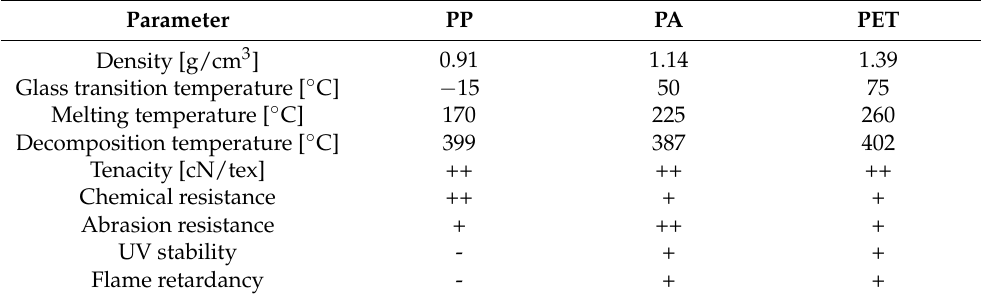
Table 1. Parameters for the physical properties of petrochemical polymers (++ very good, + sufficient, - insufficient [5–11]. Parameter PP PA PET Density [g/cm 3 ] 0.91 1.14 1.39 Glass transition temperature [ ◦ C] − 15 50 75 Melting temperature [ ◦ C] 170 225